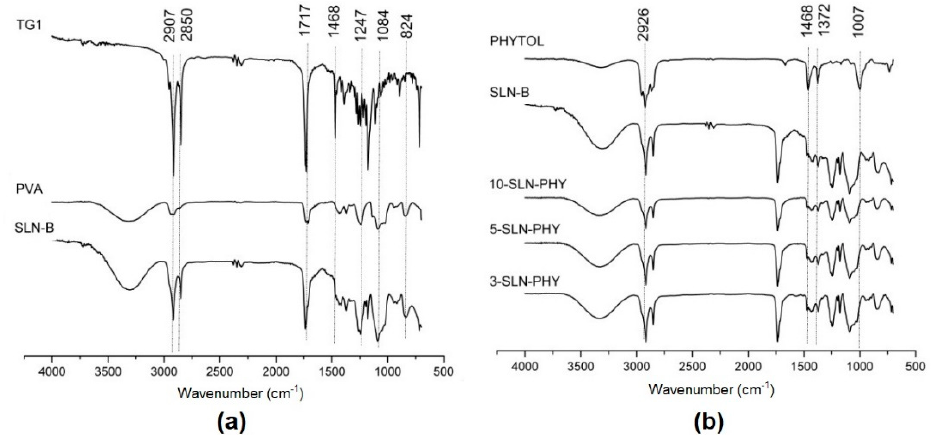
Figure 3. Attenuated total reflectance Fourier transform infrared (ATR-FTIR) spectra for compounds and different formulations of SLN. ( a ) Spectra for TG1, PVA, and blank-solid lipid nanoparticles (SLN-B); ( b ) spectra for phytol, SLN-B, and phytol-loaded nanoparticles (SLN-PHY).